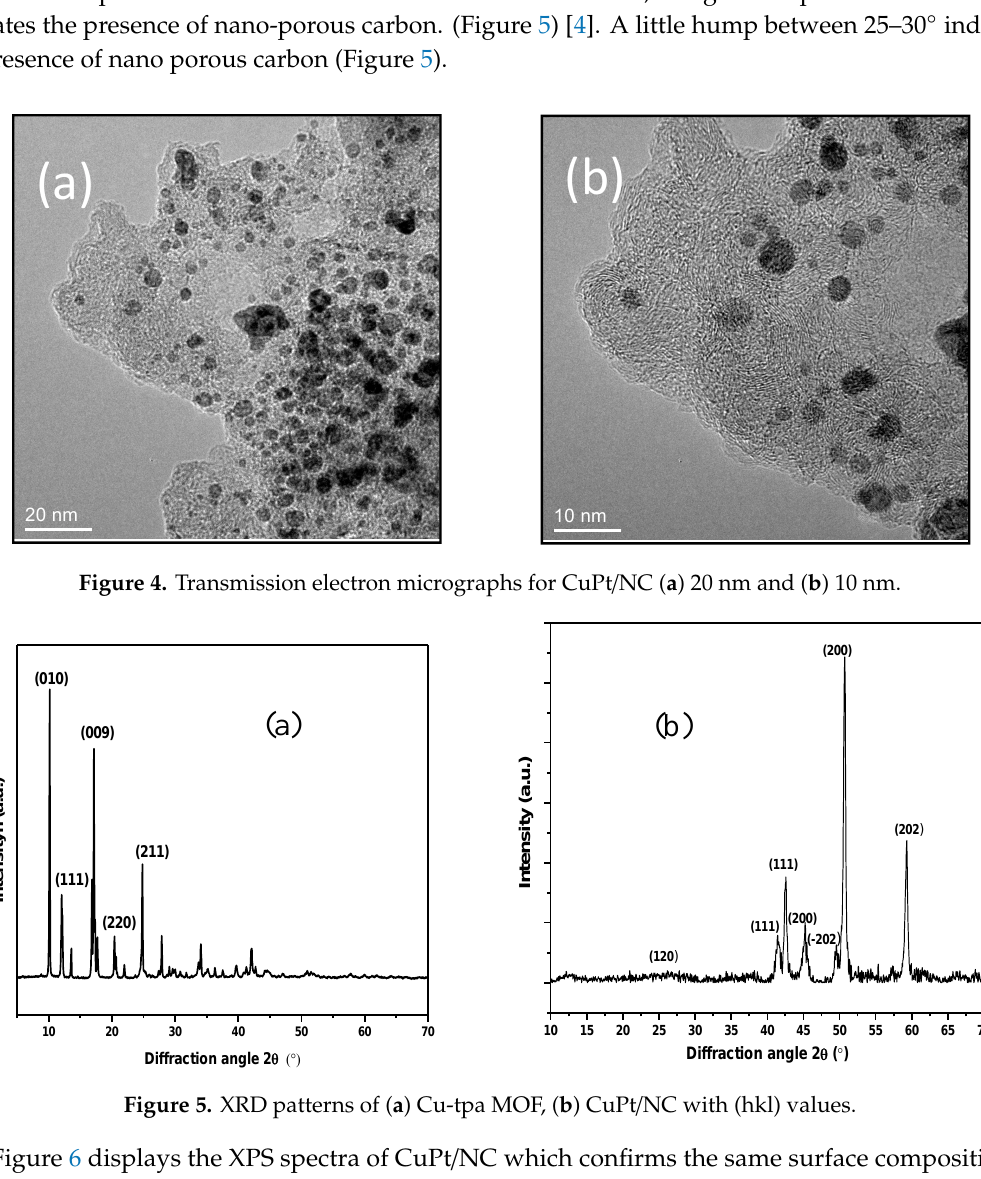
Figure 3. Energy dispersive X-ray spectroscopy of ( a ) Cu-tpa MOF, ( b ) Cu/NC, ( c ) CuPt/NC .